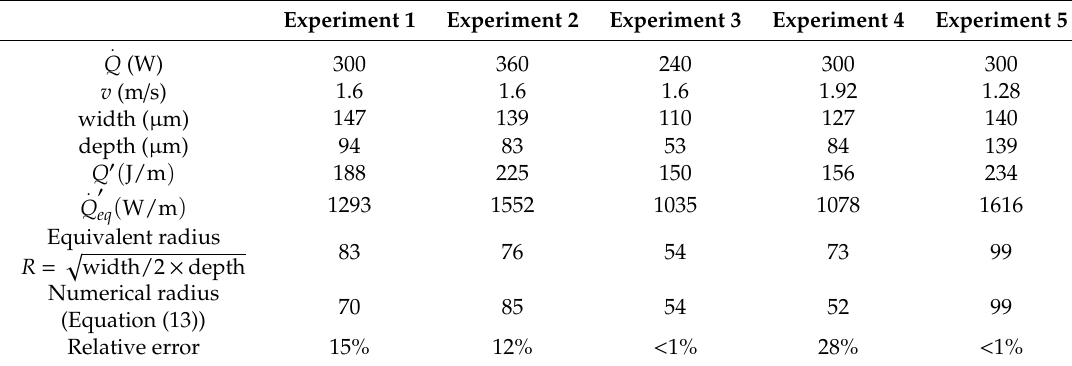
Table 2. SLM experiments using the alloy IN718. In the table we show the data of the five experiments, the equivalent heat source, the equivalent radius of the elliptical pool, and the radius calculated using Equation